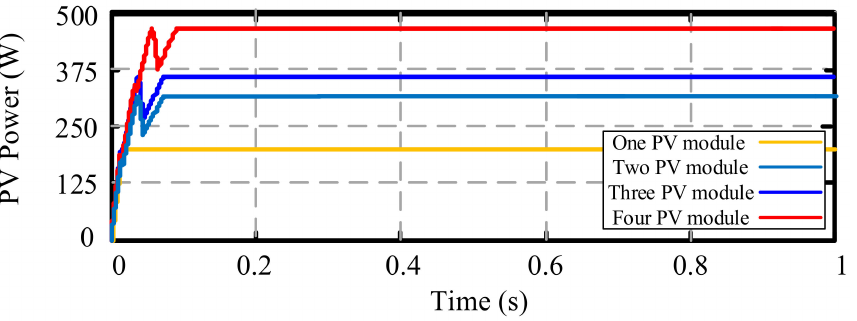
Figure 13. PV power curve for different PV modules for DSM based FLC at partially shaded mode.